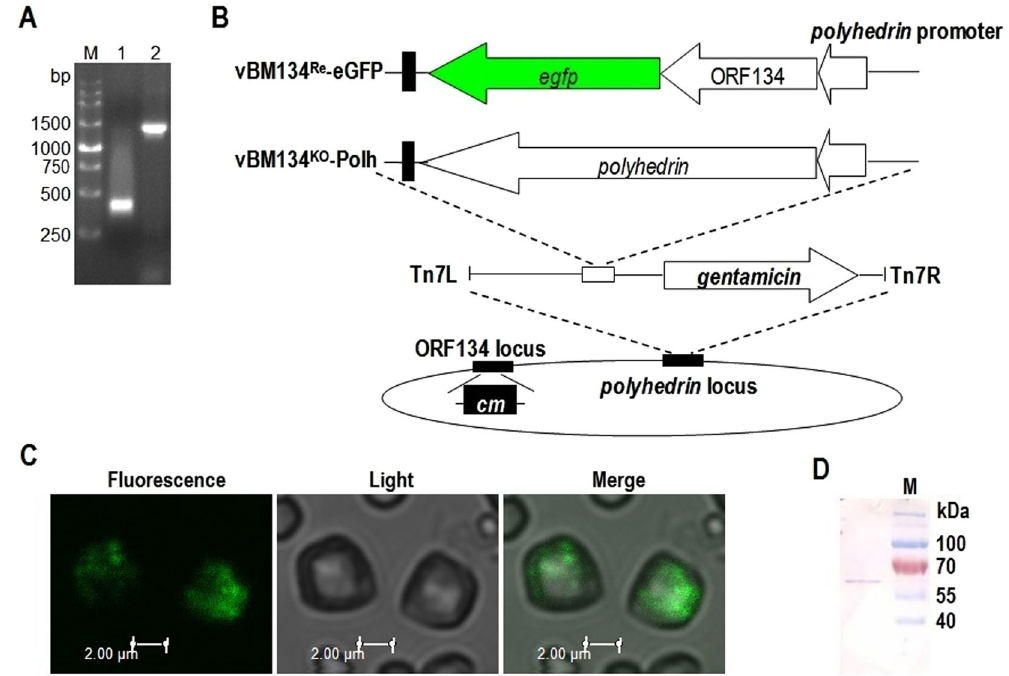
Figure 6. BM134 as a carrier to incorporate eGFP into the polyhedra matrix. ( A ) PCR identification of the ORF134 knockout bacmid. Lane M, DNA marker. Lane 1, DNA template of wildtype BmNPV bacmid and lane 2, template of the ORF134-disrupted bacmid, vBM134 KO . ( B ) Construction of the BM134-eGFP-encoded nucleotide sequence- and polyhedrin -inserted bacmids vBM134 Re -eGFP and vBM134 KO -Polh. ( C ) Fluorescence of the polyhedra purified from BmN cells co-infected with viral stocks of vBM134 Re -eGFP and vBM134 KO -Polh. ( D ) Western blot analysis of purified polyhedra immobilized with the fusion protein BM134-eGFP using a mouse monoclonal anti-eGFP antibody. Lane M, pre-stained protein